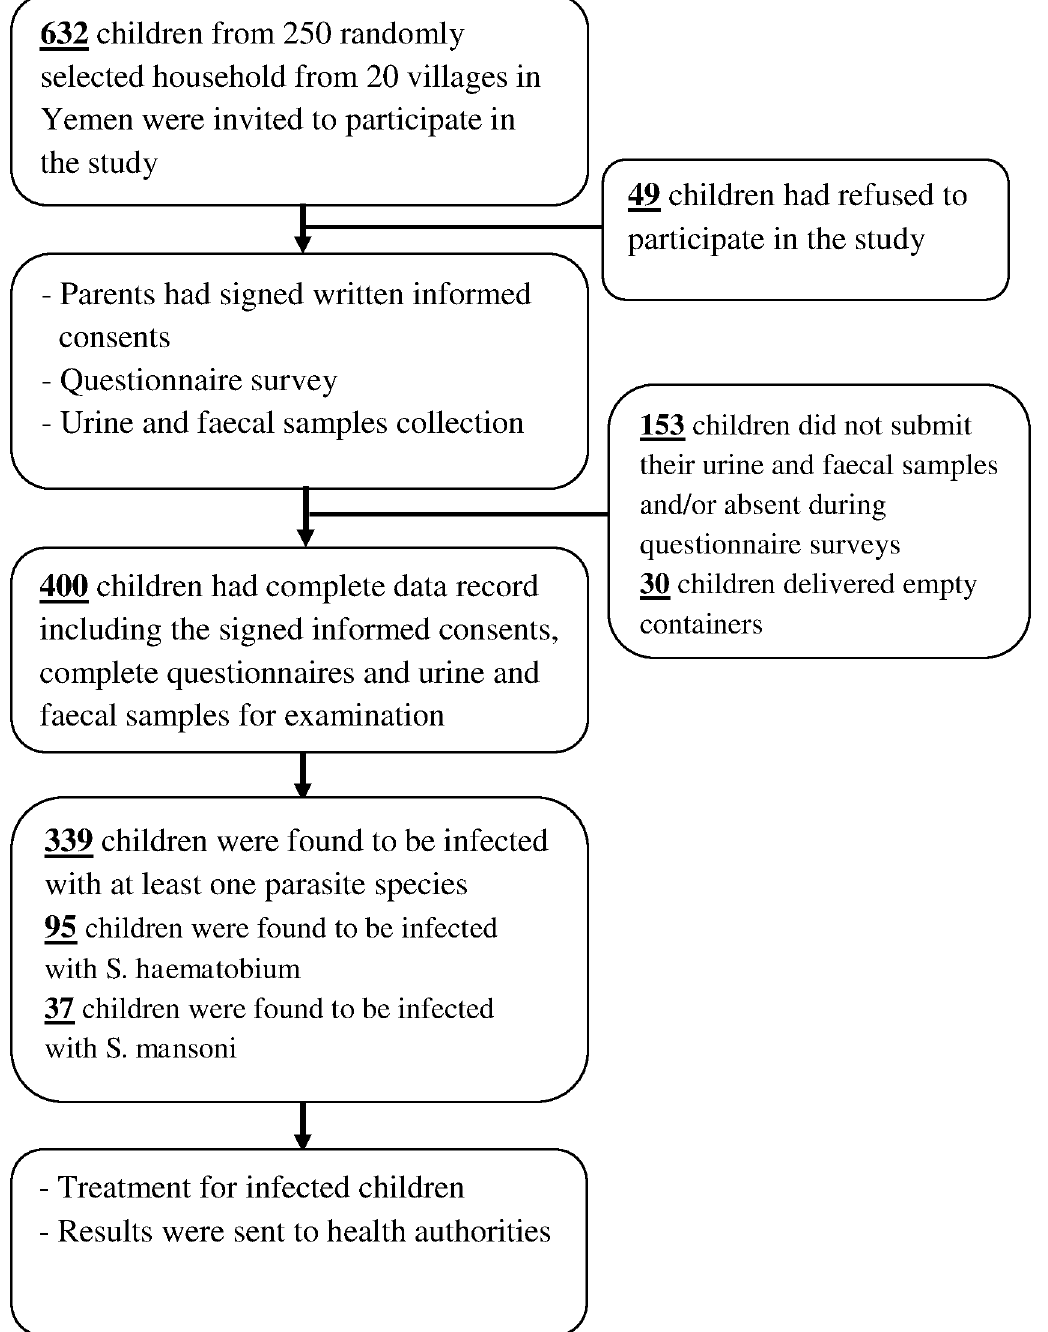
Figure 2. Flow chart of the participation and compliance in the present study.